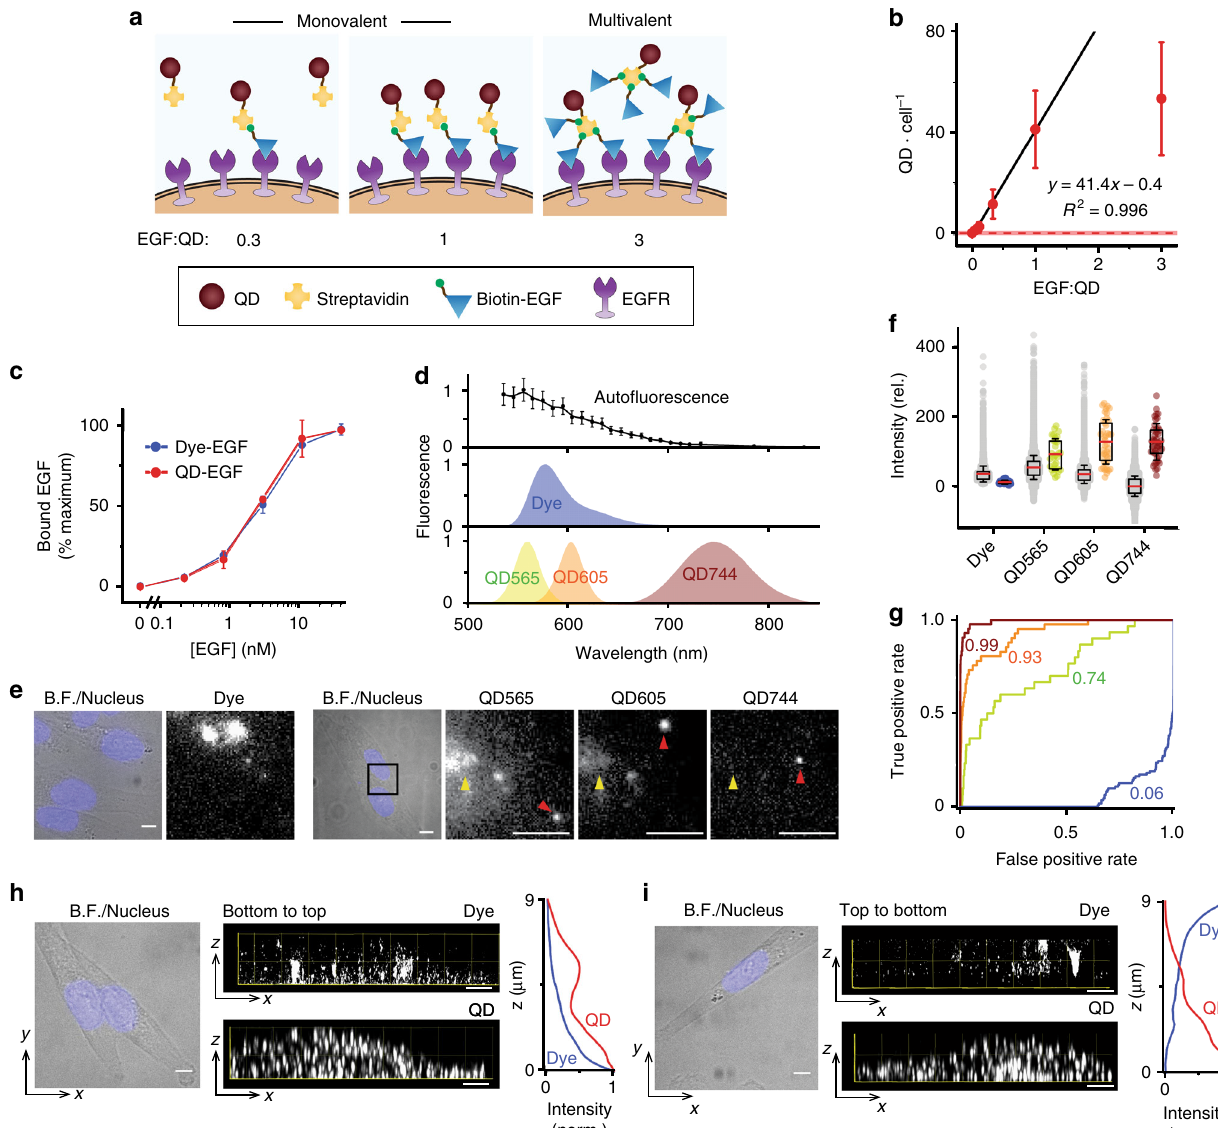
Fig. 2 Functional and optical characterization of epidermal growth factor (EGF) conjugates of dyes and quantum dots (QDs). a Schematics show assembly of QD-EGF conjugates with controlled valency through biotin-streptavidin conjugation. b Experimental relationship between QDs bound per cell versus EGF:QD conjugation ratio. The red dashed line indicates the average number of QDs per cell for QDs alone, with red shade indicating the background standard deviation. MDA-MB-231 cells were treated with QD-EGF conjugates at 0.5 nM for 10 min on ice. N ≥ 10 cells. c Speci fi c binding isotherm for dye- EGF and QD744-EGF to MDA-MB-231 cells measured by fl ow cytometry. Raw data are shown in Supplementary Figure 3. N = 2. d Fluorescence spectra of dye and QDs used in this work and mean auto fl uorescence, in arbitrary units. For auto fl uorescence, N ≥ 13 cells. e Representative images of auto fl uorescence, dye-EGF, QD565-EGF, QD605-EGF, and QD744-EGF bound to cell, measured in their respective spectral bands. All QD-EGF were bound to the same cell. The black square in each bright fi eld (BF)/nucleus micrograph indicates the zoom-in area shown in the fl uorescence images. Yellow arrows indicate auto fl uorescence; red arrows indicate dyes or QDs. f Two-dimensional intensities of auto fl uorescence, single dye and single QDs. The box indicates 25/75th percentile; red lines are the mean value; whiskers are s.d.; N ≥ 30 for dye and QDs; N > 20,000 spots for auto fl uorescence at each wavelength. g Receiver operating characteristic (ROC) curve showing higher detection accuracy of single QD744 (dark red) compared with dye (blue), and QD565 (green) or QD605 (orange) in the presence of auto fl uorescence shown in f . Numbers indicate areas under the ROC curves (AUROC). h Representative BF/nucleus micrograph with orthogonal 3D fl uorescence images of dye-EGF and QD744-EGF bound to the same cell, imaged from the bottom of the cell to the top. A z-projection of summed fl uorescence intensity of dye-EGF and QD-EGF is shown at right. i Same as h , but fl uorescence images were acquired from the top of the cell to the bottom. In b - d , points indicate mean ± s.d. In e , h , and i , scale bars, 5 μ experimental replicates (Fig. 4b and Supplementary Figure 8a) kinetic binding model 12,28,39 to known distributions of EGFR and EGF distributions fi t well to gamma distributions ( p ≥ 0.79 by expression in MDA-MB-231 cells 37,38,40 , with ligand binding χ 2 test) (Fig. 4c, red regressions), insinuating a correlation with further distributed by a Poisson to simulate ligand binding intrinsic distribution in receptor number 2,5,37,38 . We simulated probabilities per cell (see Methods). The experimental EGF the bound ligand distribution by applying a ligand – receptor binding distribution matched simulations well both at 37 °C